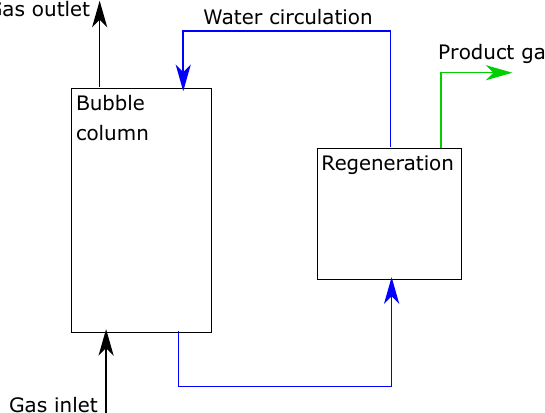
Figure 1. Illustration of the studied bubble column